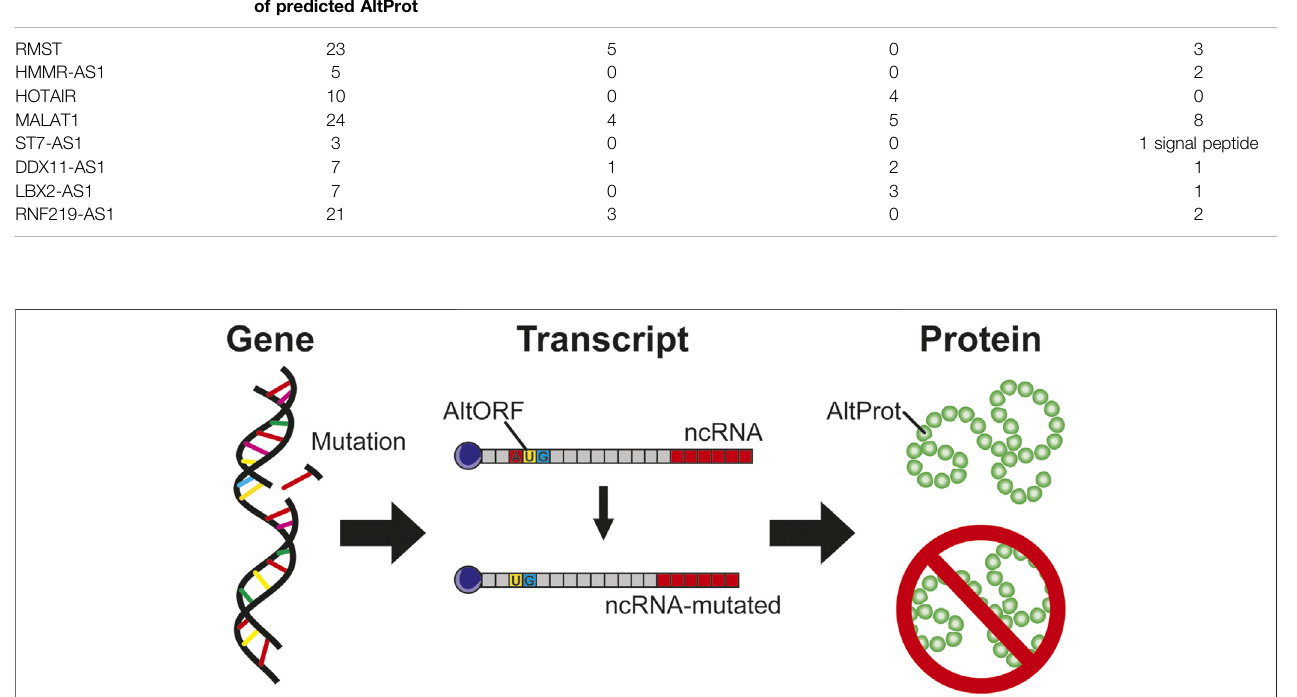
FIGURE 5 | Gene mutations, if they impact region transcript in ncRNA, are considered as silent mutation without protein impact. In the case of AltProt expression, this kind of mutation can have a severe impact similar to the deletion of a start codon leading to the inhibition of the AltProt expression.